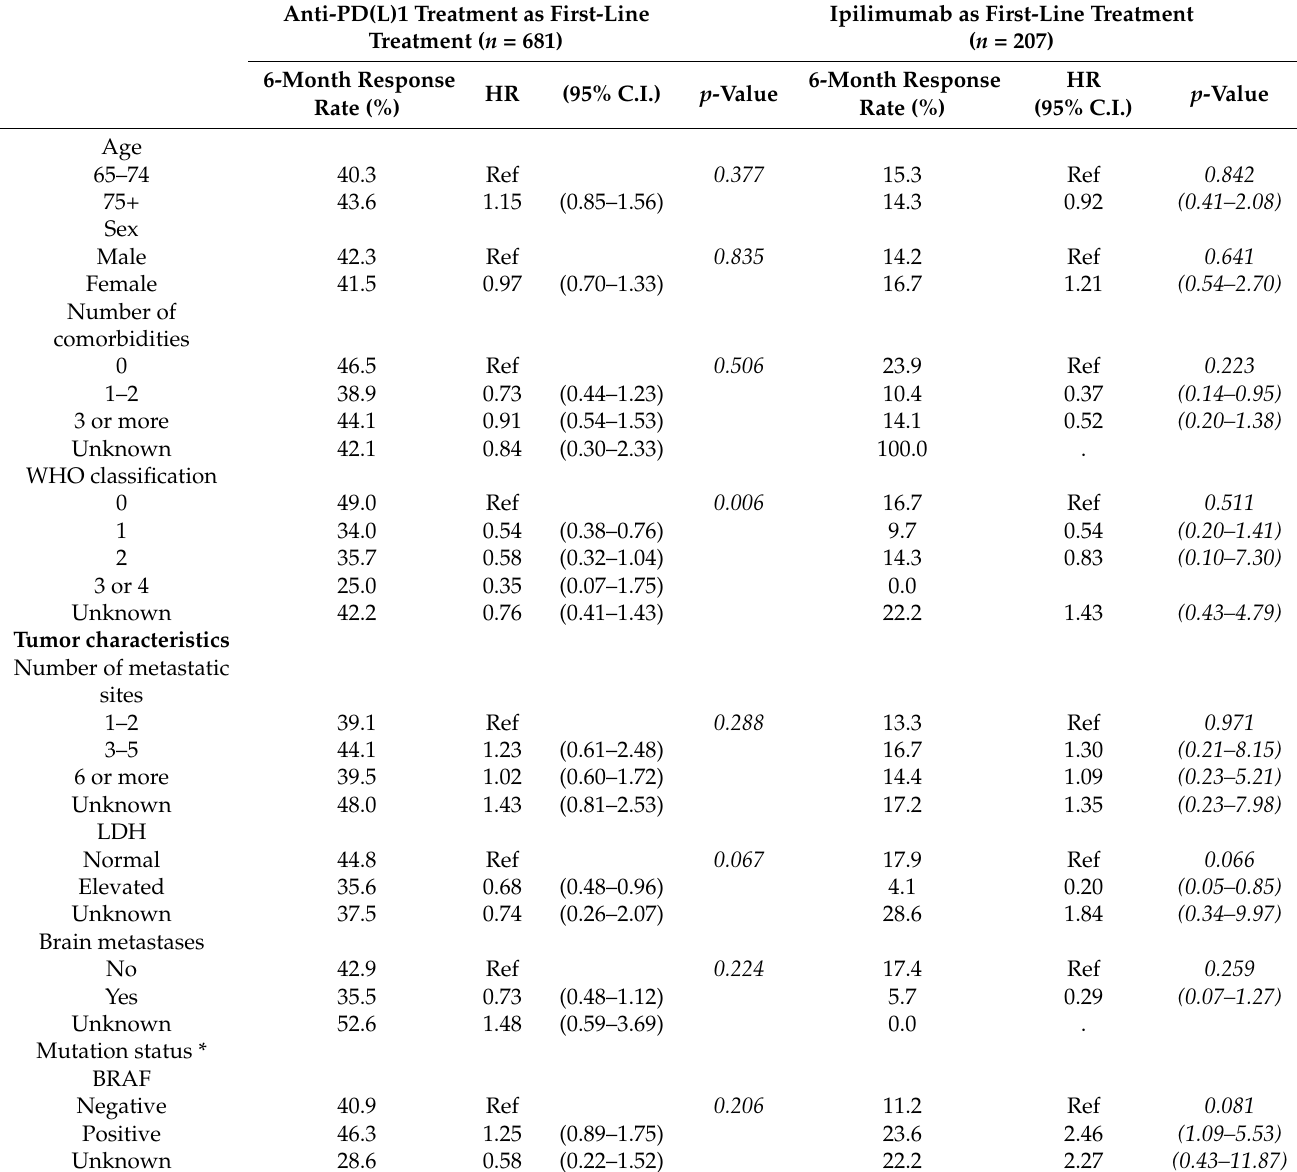
Table 3. Determinants of response to first-line treatment after 6